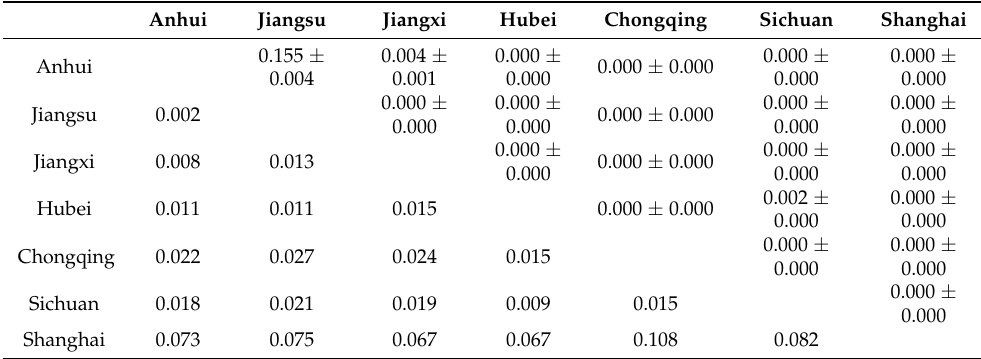
Figure 2. UGPMA ( a ) and DAPC ( b ) analysis of Ae. albopictus population structure based on microsatellite loci in the Yangtze River Basin. The x -axis for Figure 2a stands for the Dice Coefficient of Similarity. For Figure 2b, eighty first principal components (PCs) and six discriminant eigenvalues were retained during the analyses to describe the relationship between the clusters. The axes represent the first two linear discriminants (LD). Each circle represents a cluster and each colour represents the different subpopulations identified by the DAPC. Table 3. Genetic difference (F ST ) among 22 Ae. albopictus populations sampled from seven locations of the Yangtze River Basin.